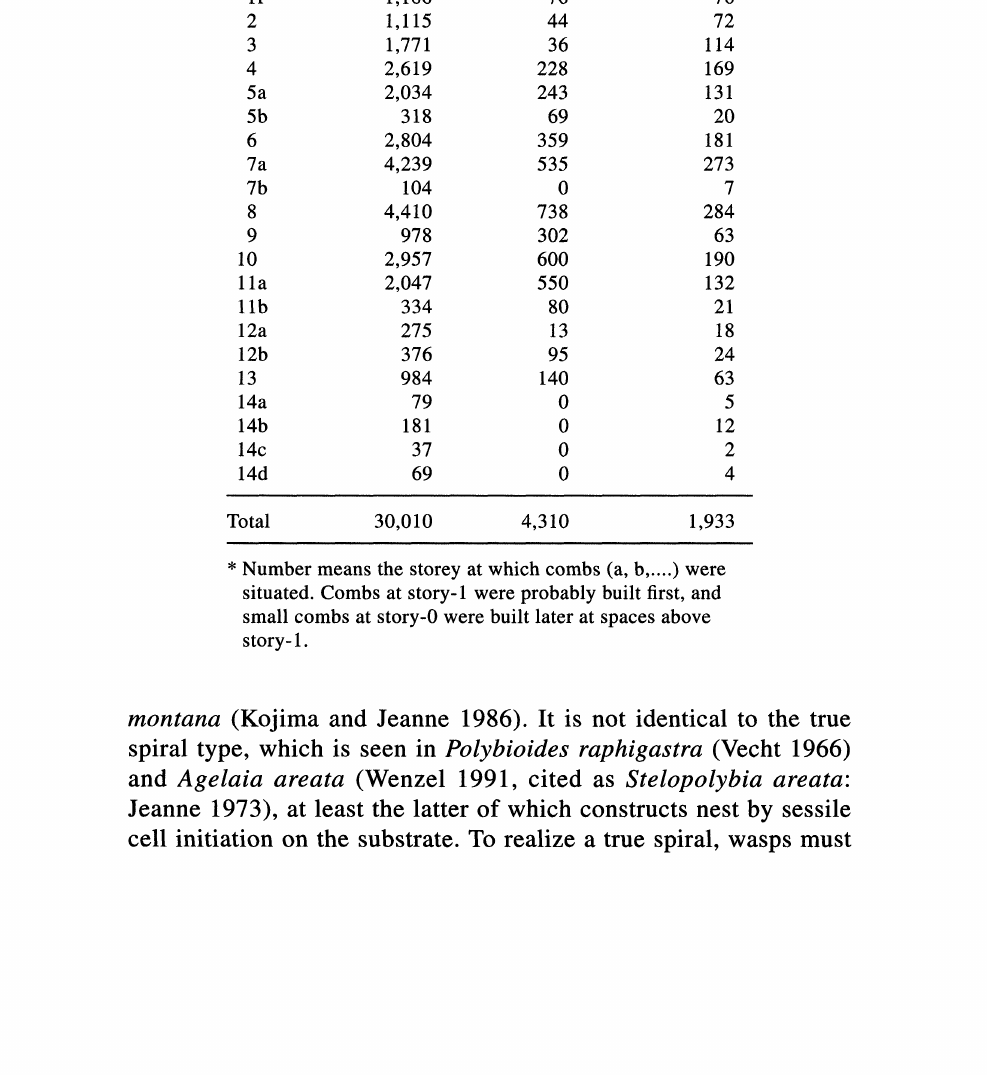
Table 3. Comb and cell compositions of Nest RM862 col- lected on 13 October 1986 at CSIRO, Atherton. Combs* No. No. Area cells